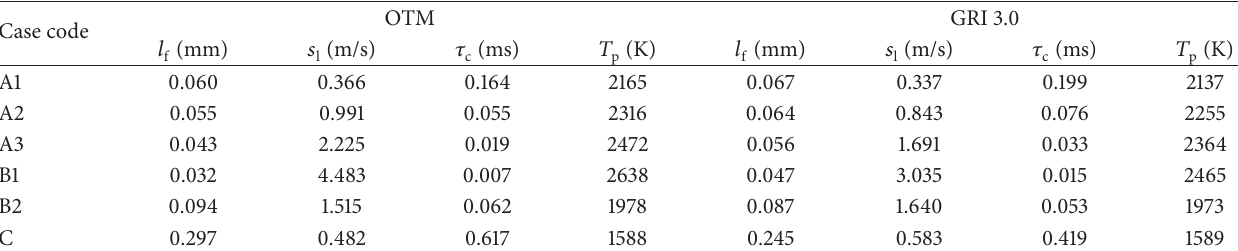
Figure 3: (a), (b) Velocity, (c) temperature, and (d) NO 𝑥 mole fraction profiles of 1D freely propagating flame. Table 2: Detailed results of 1D laminar